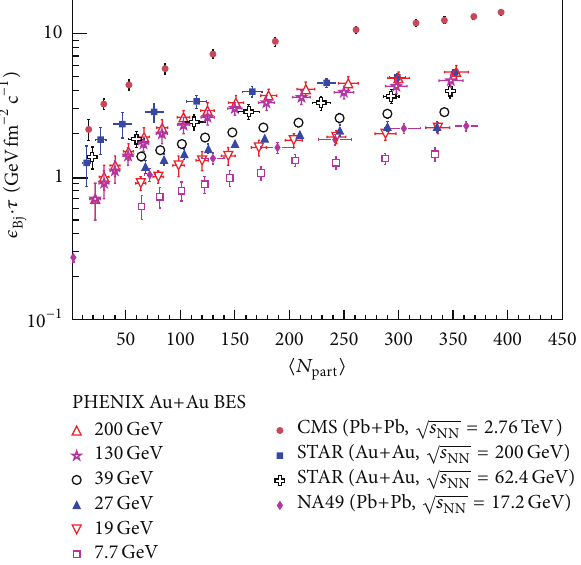
Figure 42: The 𝑁 dependence of the product of the Bjorken part ⋅ 𝜏 ) for Au+Au system energy density and the formation time ( 𝜖 Bj at different energies at RHIC compared to Pb+Pb collisions at